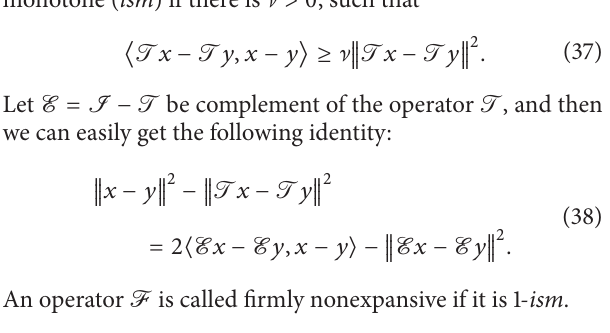
compute 𝑢 𝑘 according to Chambolle method (31) and